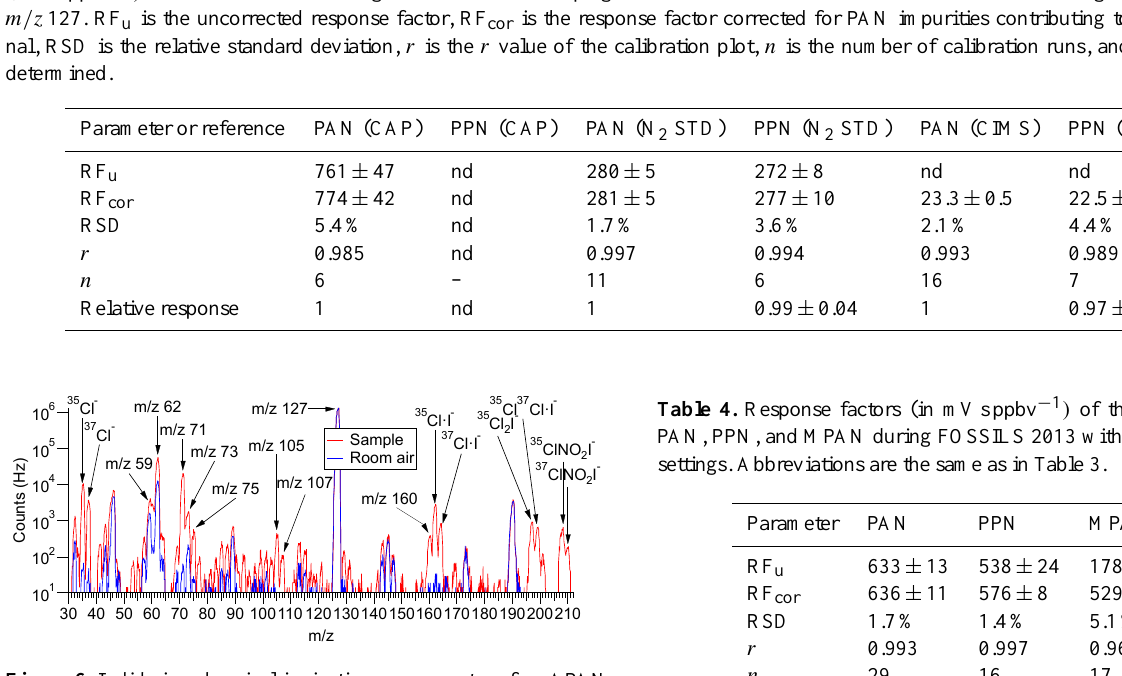
Figure 6. Iodide ion chemical ionization mass spectra of an APAN standard and room air.